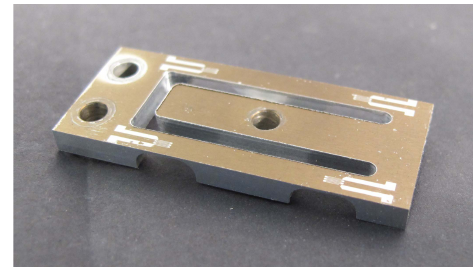
Figure 6. Deformation element with four sputtered RSGs in the deflection areas.